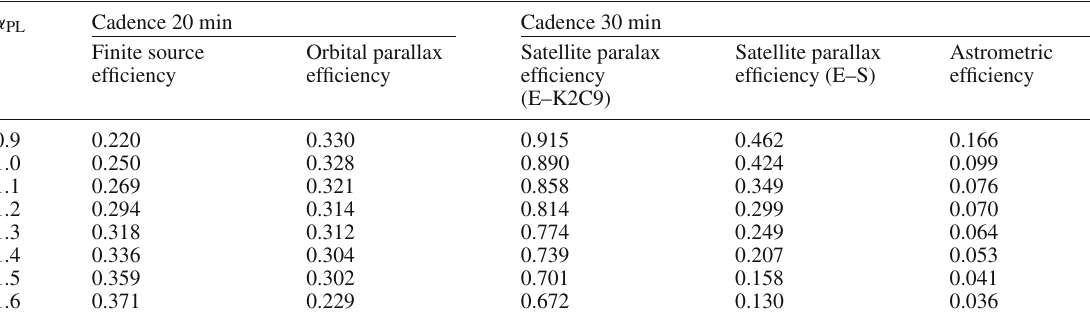
Table 1 Efficiency of some second-order effects in microlensing events caused by FFPs towards the Galactic bulge as a function of the α PL value in the range 0.9–1.6 and for observing cadence of 20 min and 30 min α PL Cadence 20